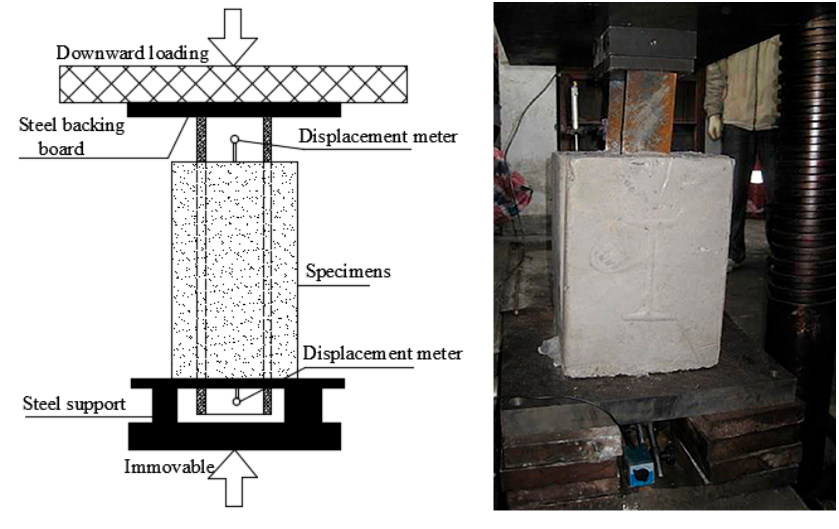
Figure 5. Loading device.